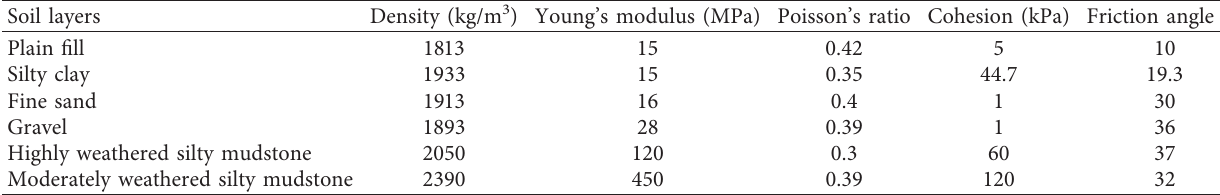
Figure 4: 3D finite difference model for the No. 1 Nanchang Metro Line tunnel. Table 2: Geomechanical parameters for different soil layers.